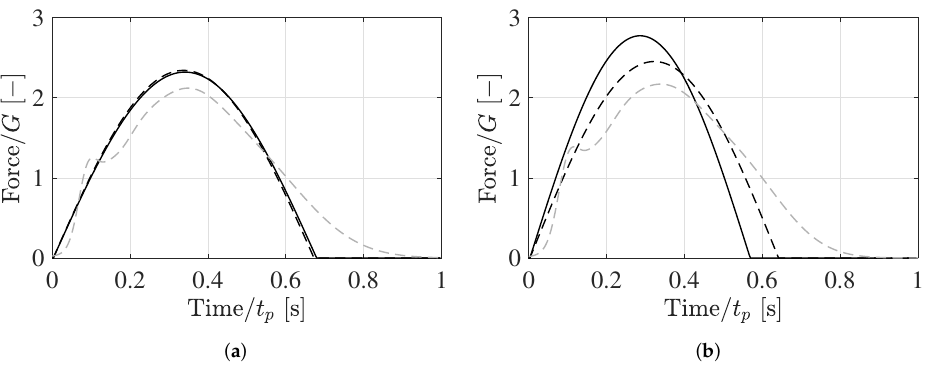
Figure 1. Single-step load pattern according to Wheeler [7], Bachmann and Ammann [8] (black, solid), Pa´ntak [11,12] (forefoot-strike, dashed, black), and Pa´ntak [11,12] (heel-strike, dashed, gray) for a pacing rate f p = 1/ t p of ( a ) 2.5 Hz and ( b ) 3.0